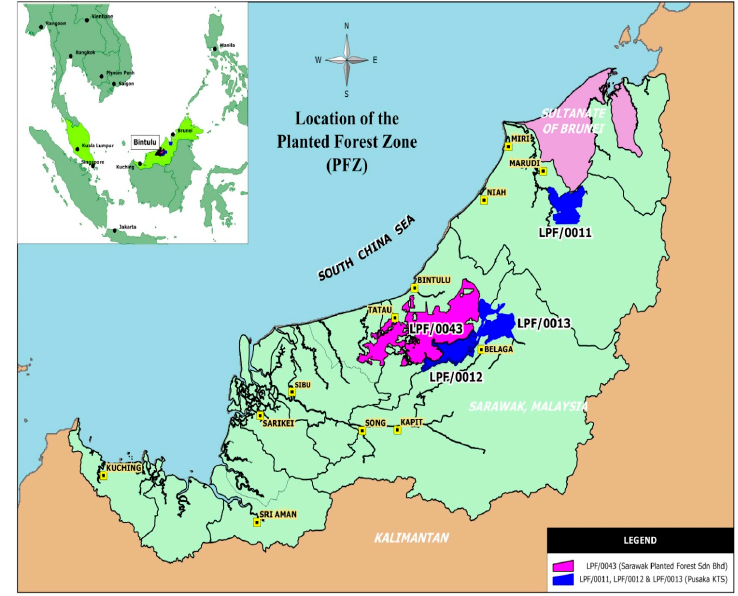
Figure 1. Location of the study sites.